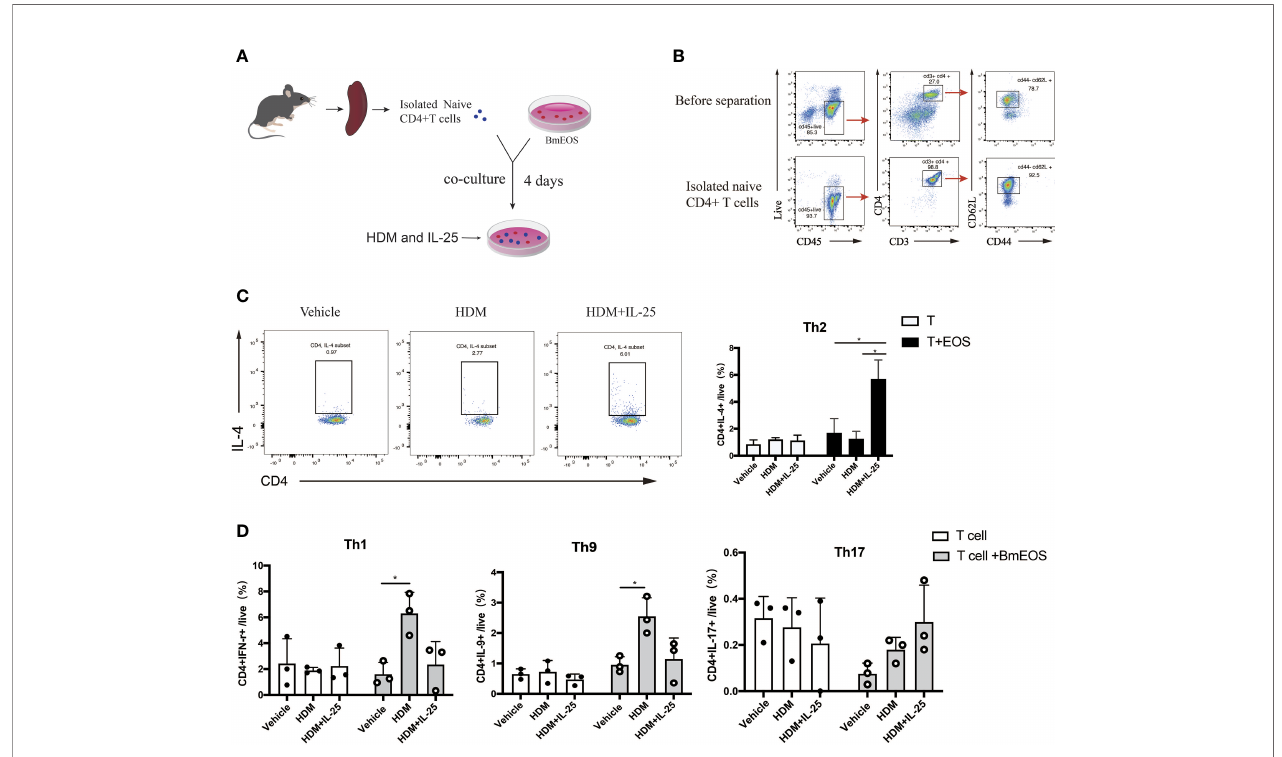
FIGURE 7 | IL-25-activated eosinophils promote Th2 polarization in vitro . (A) Schematic diagram of isolated naïve CD4 + T cells from mice and co-culture of T- BmEOS system. (B) Flow cytometry identi fi cation of isolated naïve CD4 + T cells (viable CD45 + CD3 + CD4 + CD62L + CD44 - ). (C, D) Puri fi ed naïve CD4 + T cells and BmEOS were co-cultured for 96 h with HDM in the presence or absence of IL-25. Naïve CD4 + T cells alone were also cultured. The differentiation of Th subsets was detected by fl ow cytometry. n=3, unpaired Student ’ s t test (C, D) , *p <